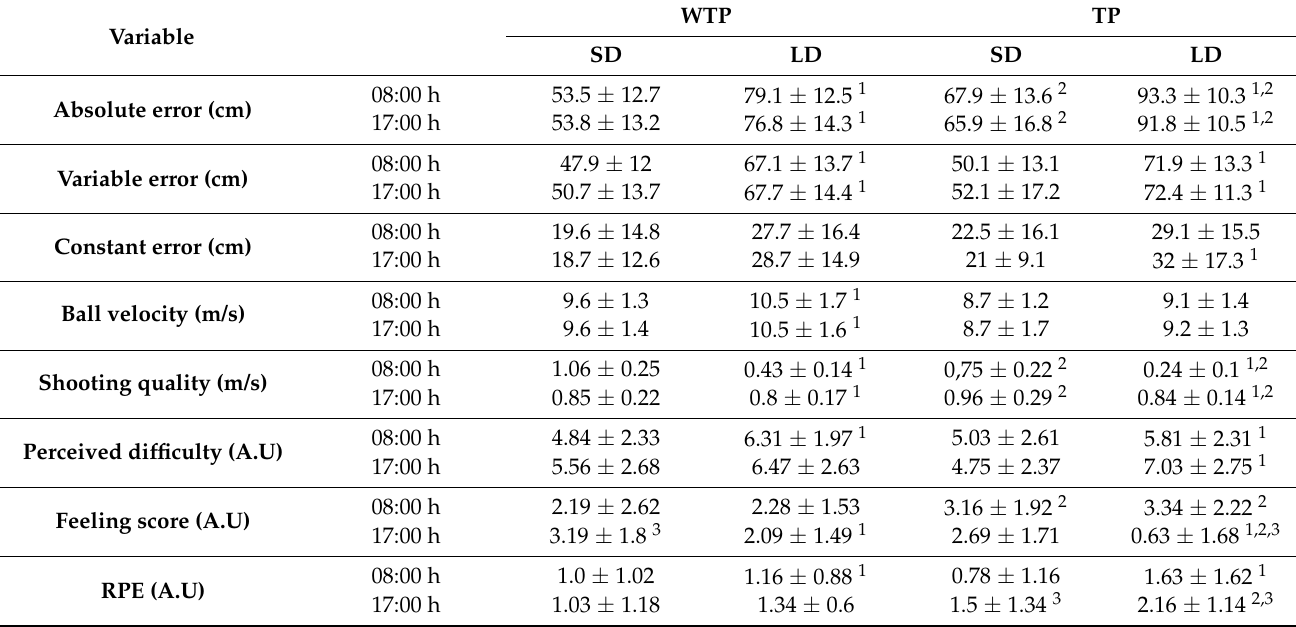
Table 1. Kicking accuracy and velocity, perceived difficulty, feeling score, and rating of perceived exertion (RPE) recorded at 08:00 h and 17:00 h during the short (SD) and long (LD) distances for the two experimental conditions (without time pressure (WTP) and with time pressure